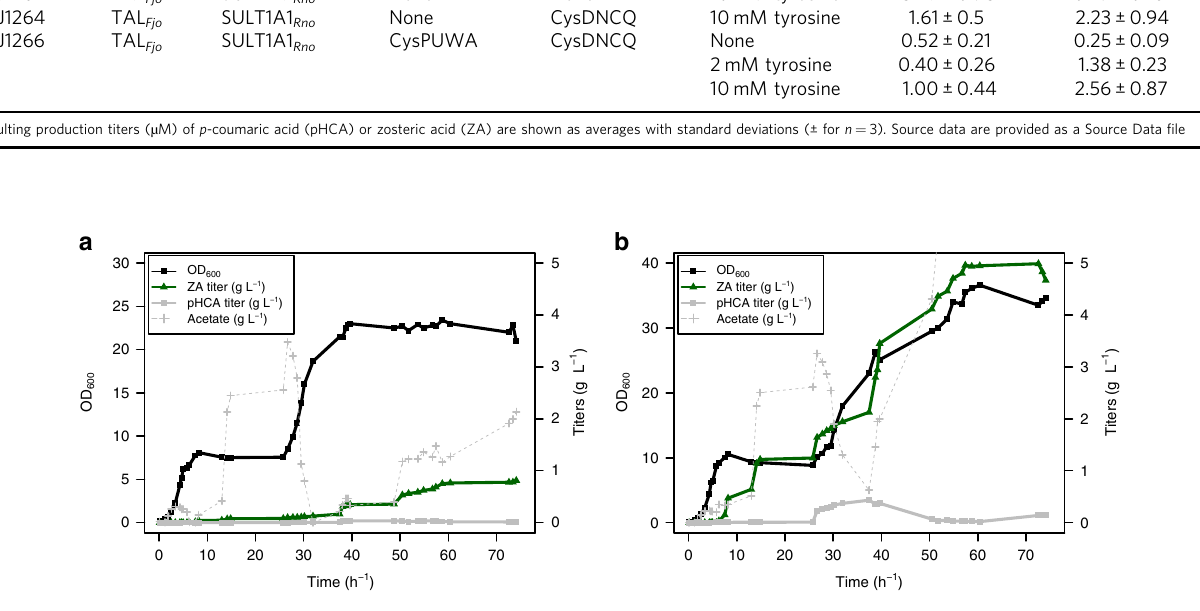
Fig. 5 Production of zosteric acid in fed-batch bioreactor cultivation. Growth and production in a 1-L fermenter under fed-batch conditions in minimal salts media without tyrosine ( a ) or with supplementation of exogenous tyrosine ( b